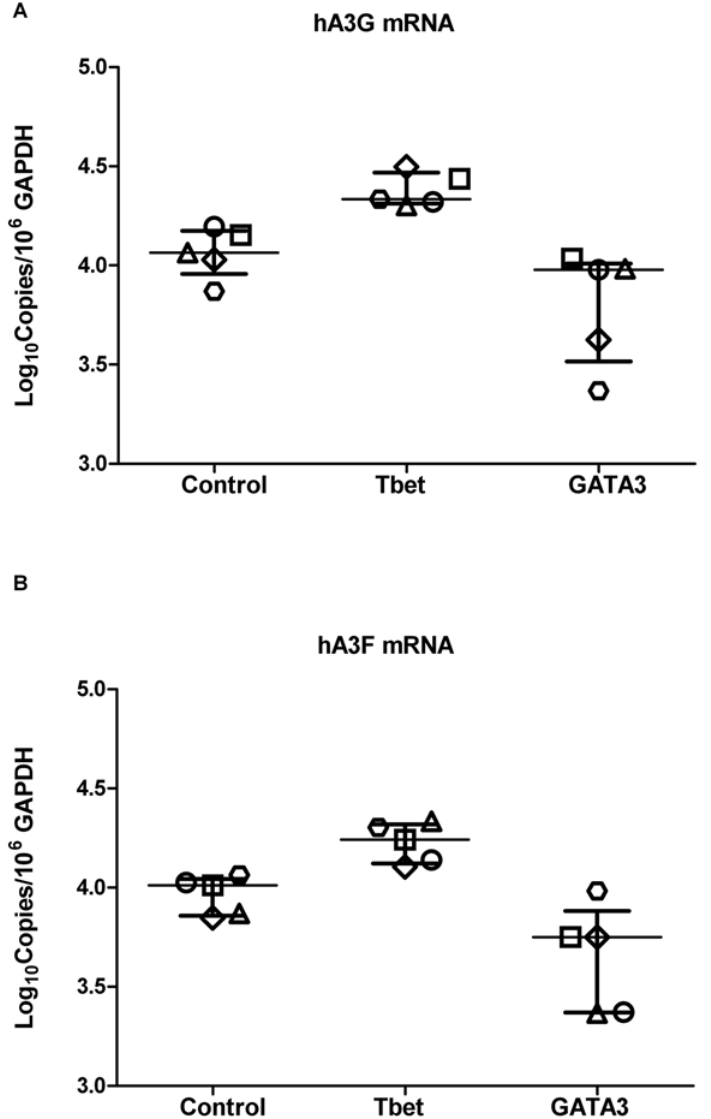
Figure 1. Tbet and GATA3 regulate hA3G and hA3F expression. Naı¨ve CD4 + T cells were transduced with a Tbet or GATA3 expressing lentiviral vector. After sorting based on GFP marker gene expression, cytoplasmic RNA was isolated and used to determine mRNA levels of hA3G (A) and hA3F (B) by qRT-PCR. Data are expressed as copy number of hA3G or hA3F per 10 6 copies of GAPDH. Error bars represent median and interquartile